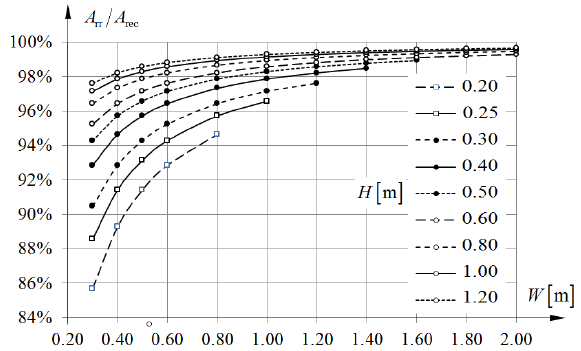
Fig. 3 Degree of use of full rectangular cross section in ducts with rounded